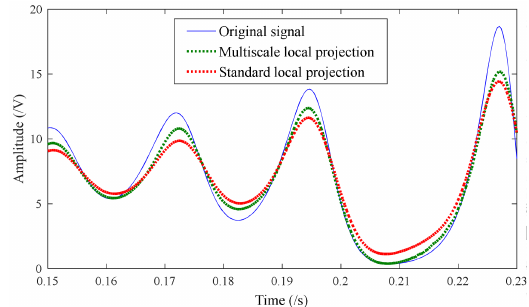
Figure 9. Local enlargement of time domain plot after noise reduction.